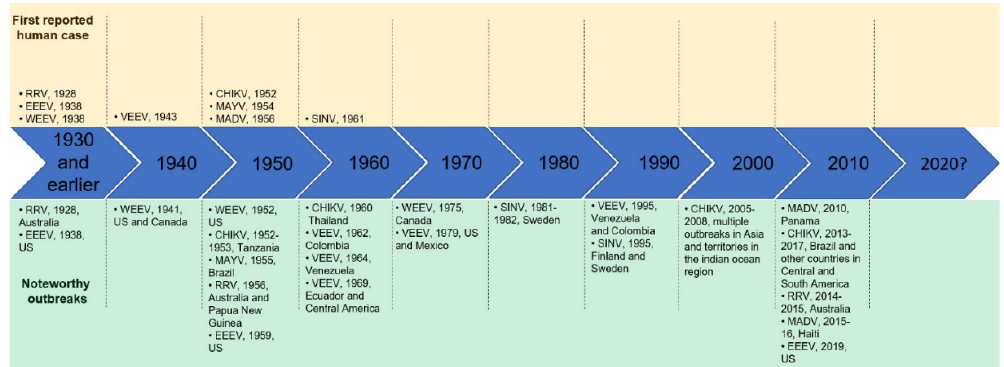
Figure 1. Alphavirus outbreak timeline . History of human alphavirus infections based on first reported human infection (Above) and important human outbreaks (Below) for each virus.